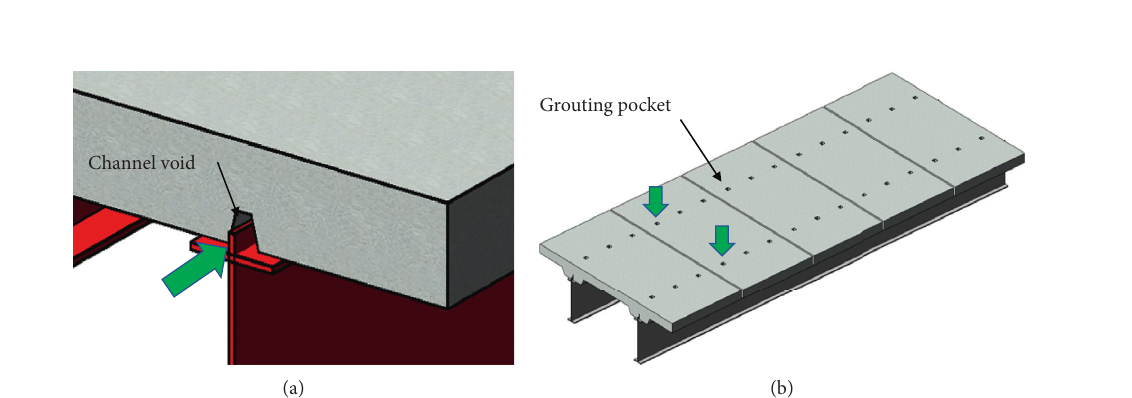
Figure 4: Two grouting methods: (a) pressure grouting; (b) self-levelling grouting.